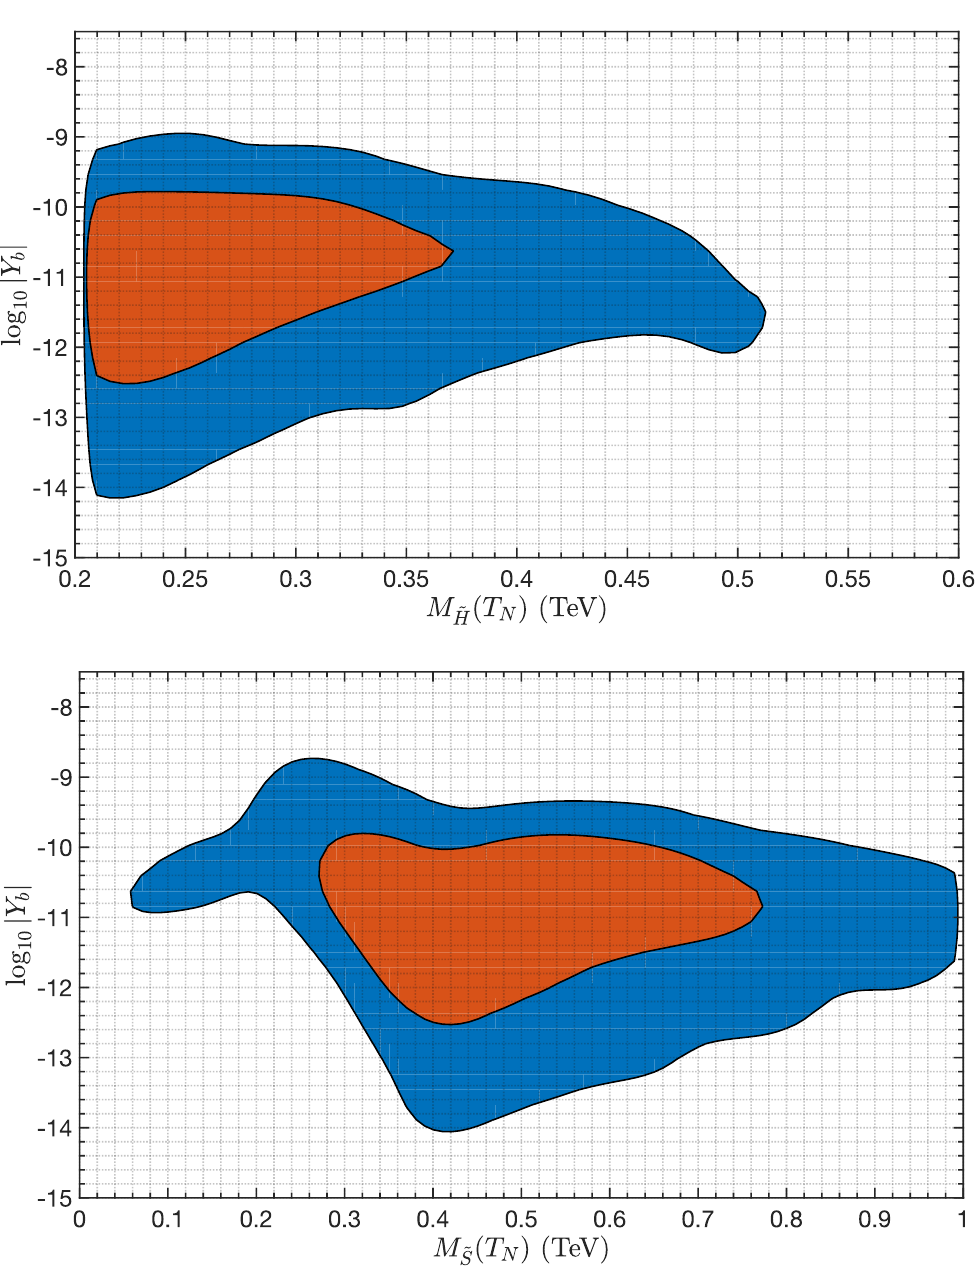
Figure 3 . Two dimensional posterior probability distribution in the baryon asymmetry, produced by the maximum CP-violating phase in the SFPT scenario, and the thermal mass of the Higgsino (top panel) and singlino (bottom panel). We colour the 1 (cid:27) and 2 (cid:27) credible regions in orange and blue, respectively.